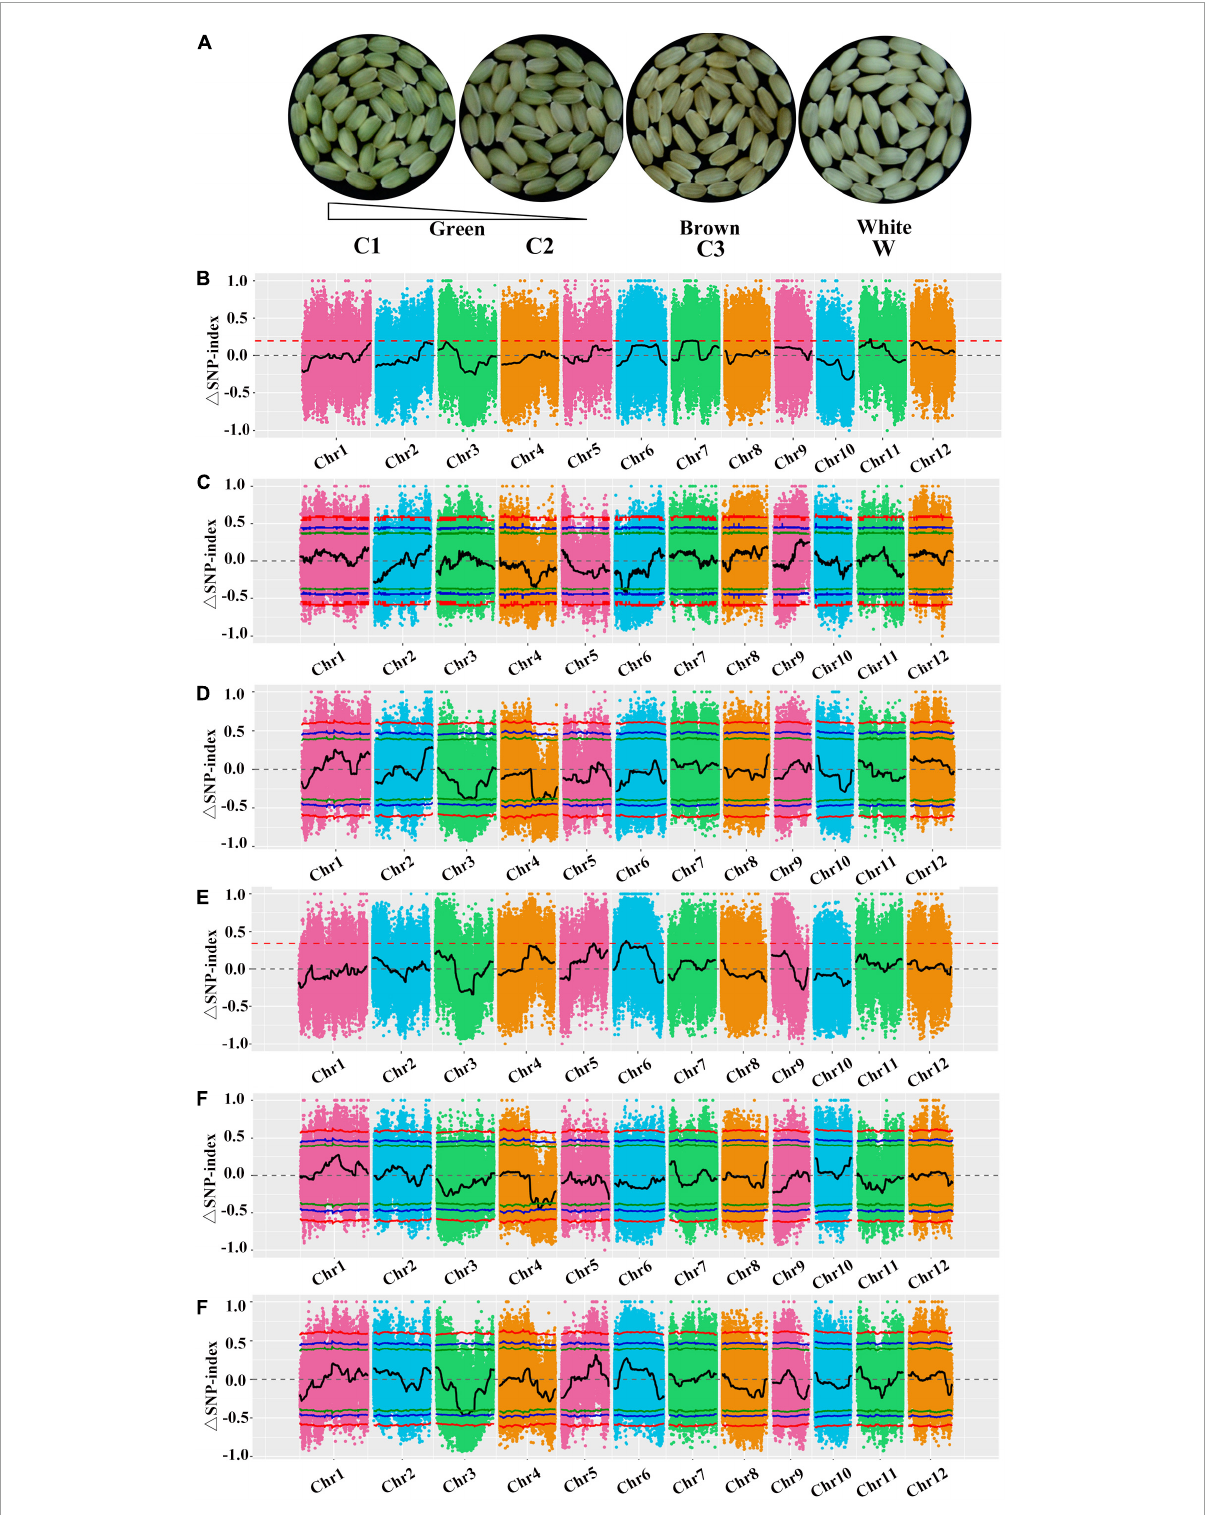
FIGURE5 Bulked segregant analysis (BSA)-seq analysis for mapping genomic regions controlling green pericarps. (A) Comparison of the pericarp colors in four bulks. (B) (cid:49) (SNP-index) plots between C1 and C2, (C) C1 and C3, (D) C1 and W, (E) C2 and C3, (F) C2 and W, and (G) C3 and W. The Y-axis presents the chromosomes, colored dots represent the calculated SNP-indices, and the black line is the fitted SNP-index. The green, blue, and red lines represent the 90, 95, and 99% threshold confidence intervals,